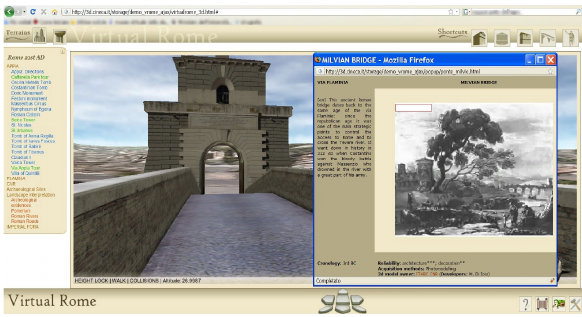
Figure 1. OSG4Web used for Virtual Rome